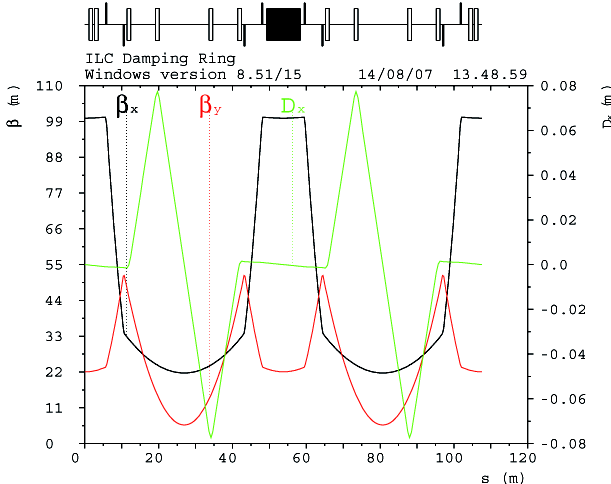
FIG. 6. (Color) Injection/extraction optics with